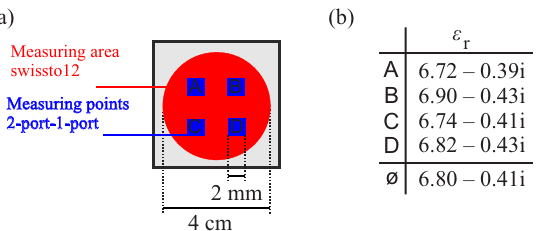
Figure 26. ( a ) Schematic drawing of the position and size of the four measuring points A, B, C, and D. ( b ) Permittivity at the measuring points for a MUT with an 18% BaTiO 3 concentration. The main differences in the extraction of the material parameters between the two measurement setups occur in the extraction of losses. The imaginary part has an maximum error of about 12.5%. This may be due to the fact that the ports are not exactly aligned and, on the other hand, due to scattering at the